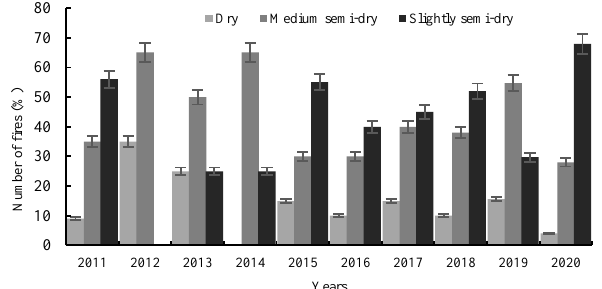
Figure 6: Frequency of fires in regional climates in the region in the studied years